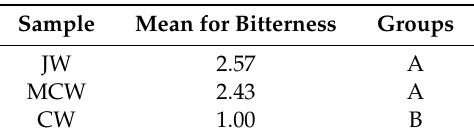
Table 3. Bitterness average ranks for each sample. Means with different letters were significantly different according to Nemenyi test (alpha = 5%).